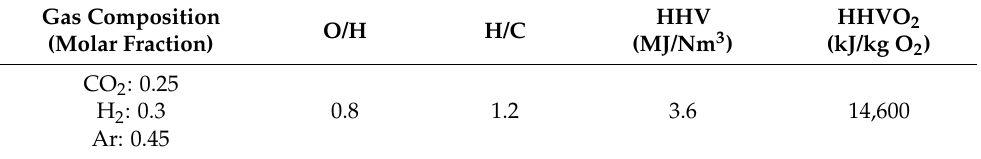
Table 1. Composition of simulated gas mixture with their respective O/H, C/H, and HHV